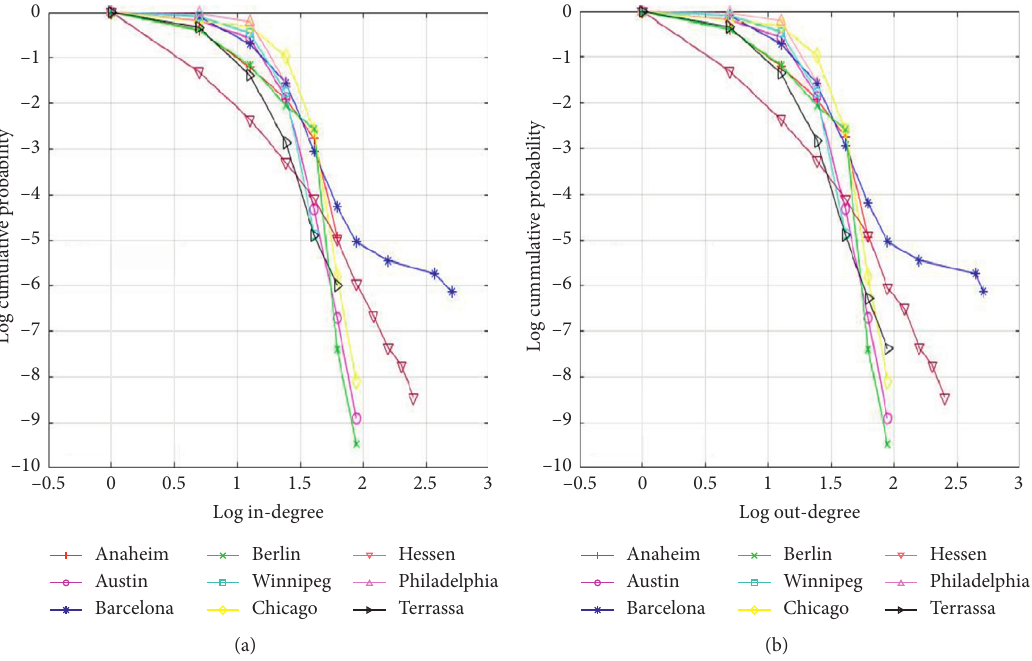
Figure 2: In-degree and out-degree distributions of urban road networks in the log-log